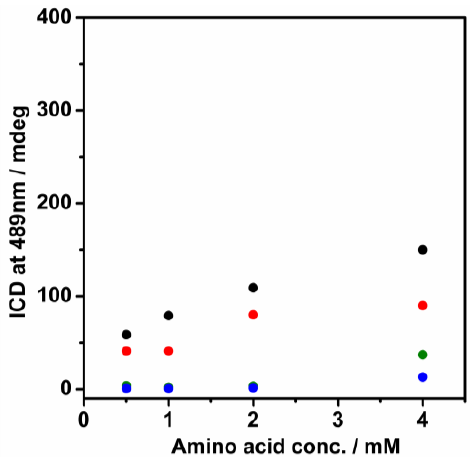
Figure 2. Intensity of the iCD at 489 nm (absolute values) versus the amino acid concentrations. Black dots represent Arg; red dots represent Lys; green dots represent His; and, blue dots represent Phe.